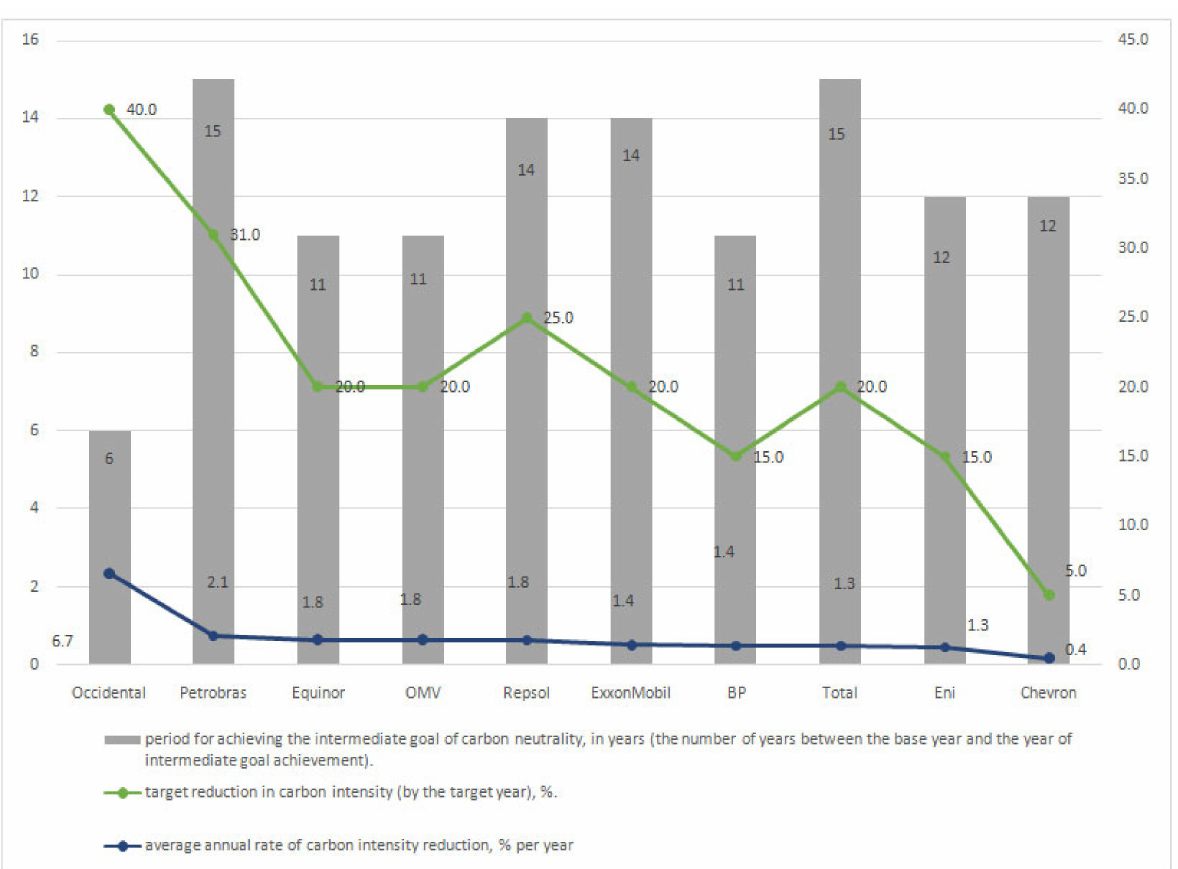
Figure 2. Companies ranked according to the average annual rate of carbon intensity reduction (% per year) (according to their declared intermediate goals). Source: compiled by the authors based on corporate reports